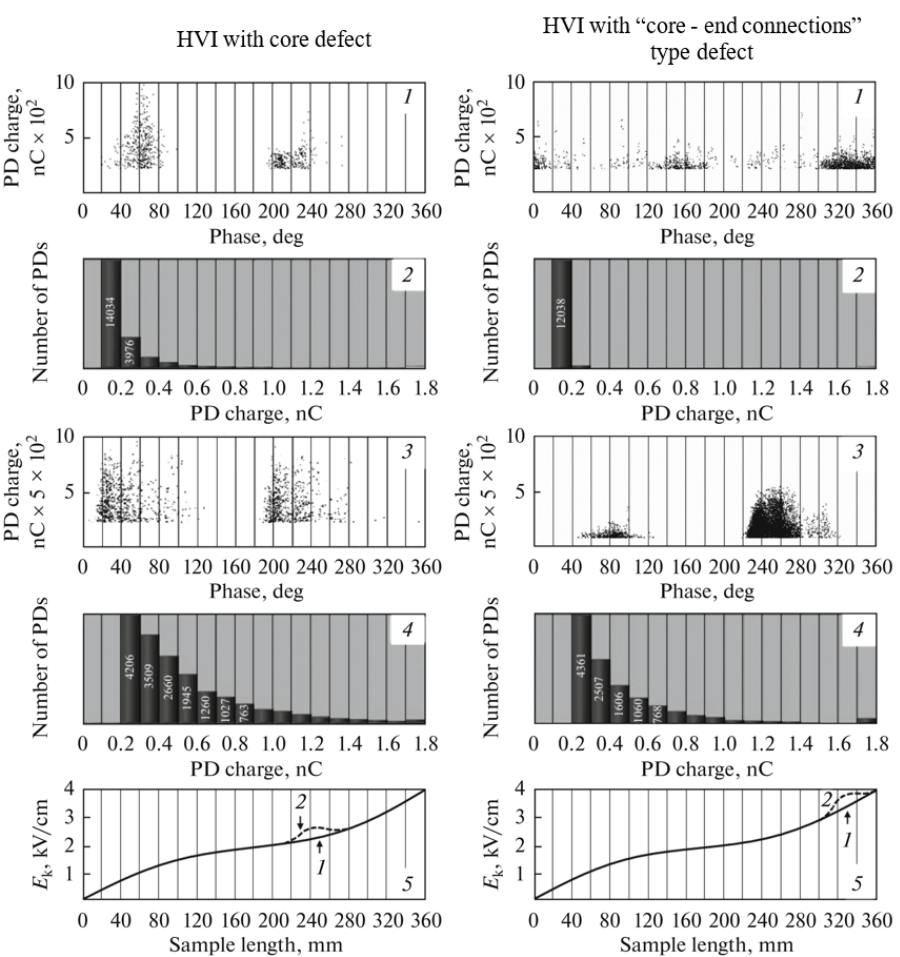
Figure 13. Parameters of PD and induced field gradients in polymer HVI, measured by electromag- netic and electro-optical sensors, respectively: 1, 2—small defects; 3, 4—large defects; and 5—spatial distribution of induced field gradients.